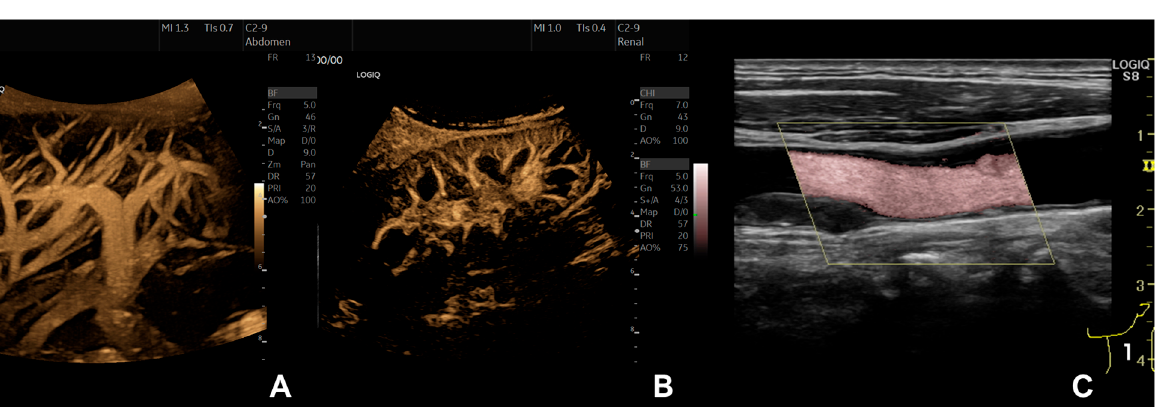
Figure 1. Flow diagram illustrating literature research.